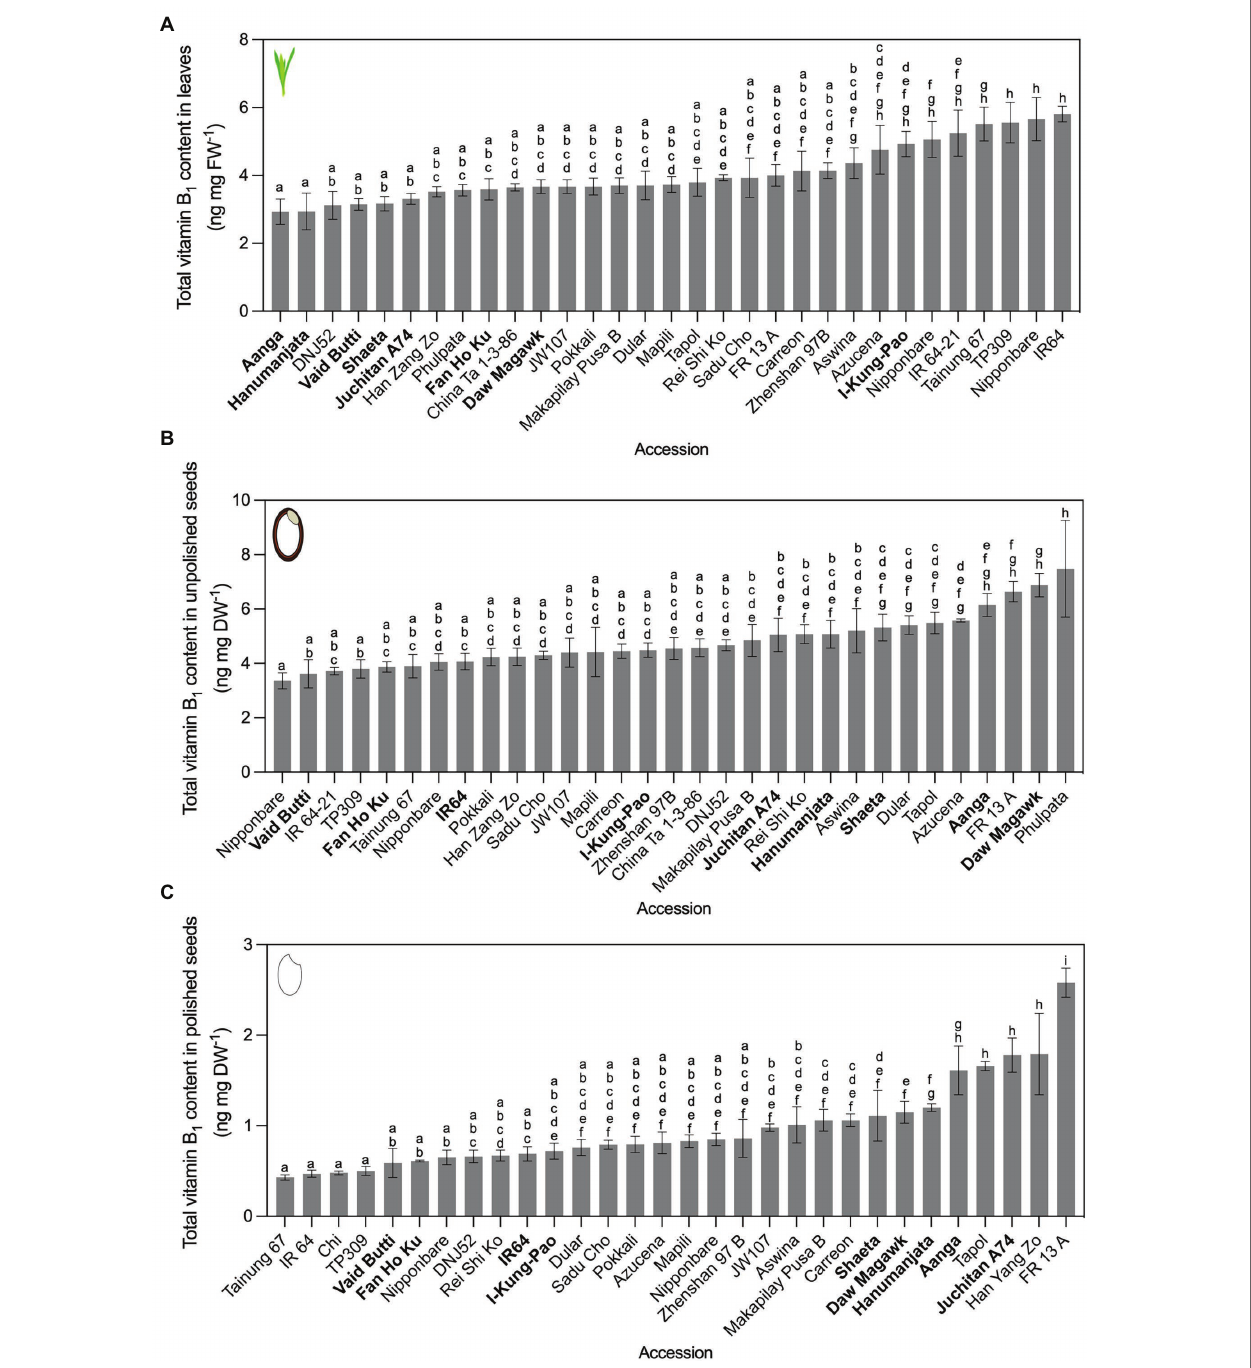
FIGURE 2 | Vitamin B 1 contents quantified by yeast assay. Leaves (A) , unpolished seeds (B) , and polished seeds (C) in rice accessions grown under greenhouse conditions and quantified by yeast assay. Twenty-one accessions cultivated in experiment 1 were re-sown, alongside 10 additional accessions from the Oryza SNP Project. The accessions with vitamin B 1 content below the 25th percentile of the distribution were considered as low vitamin B 1 accessions and those with vitamin content above the 75th percentile were considered as high vitamin B 1 accessions. Low, intermediate, and high vitamin B 1 accessions selected for HPLC analysis are in bold. Data are mean ± SD of 3 biological replicates, except Nipponbare ( n = 6), IR64 ( n = 6) and TP309 ( n = 6) for the three tissues; IR64-21 ( n = 2) for leaves; Nipponbare and IR-64-21 are n = 2 for unpolished seeds; and Nipponbare ( n = 2), IR64-21 ( n = 2) and Phulpata ( n = 0) for polished seeds. The effect of accession on total vitamin B 1 contents in panels (A–C) was determined by one-way ANOVA ( α = 0.05) with multiple comparisons and Tukey’s post-hoc test. Statistically significant differences between accessions are denoted by different